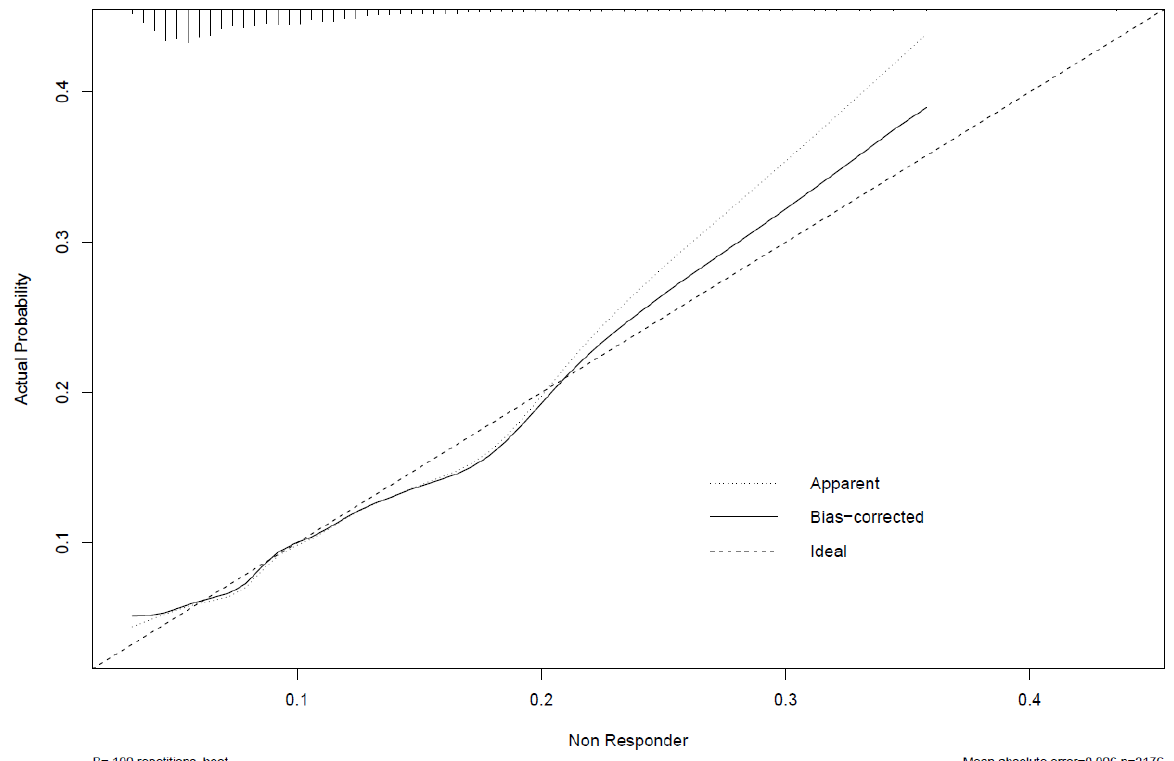
Figure 2. Calibration curve. The x-axis represents the nomogram-predicted probability, the y-axis represents the empirically observed probability and the dashed diagonal line depicts perfect agreement between the predicted and observed probability of non-response to THR.